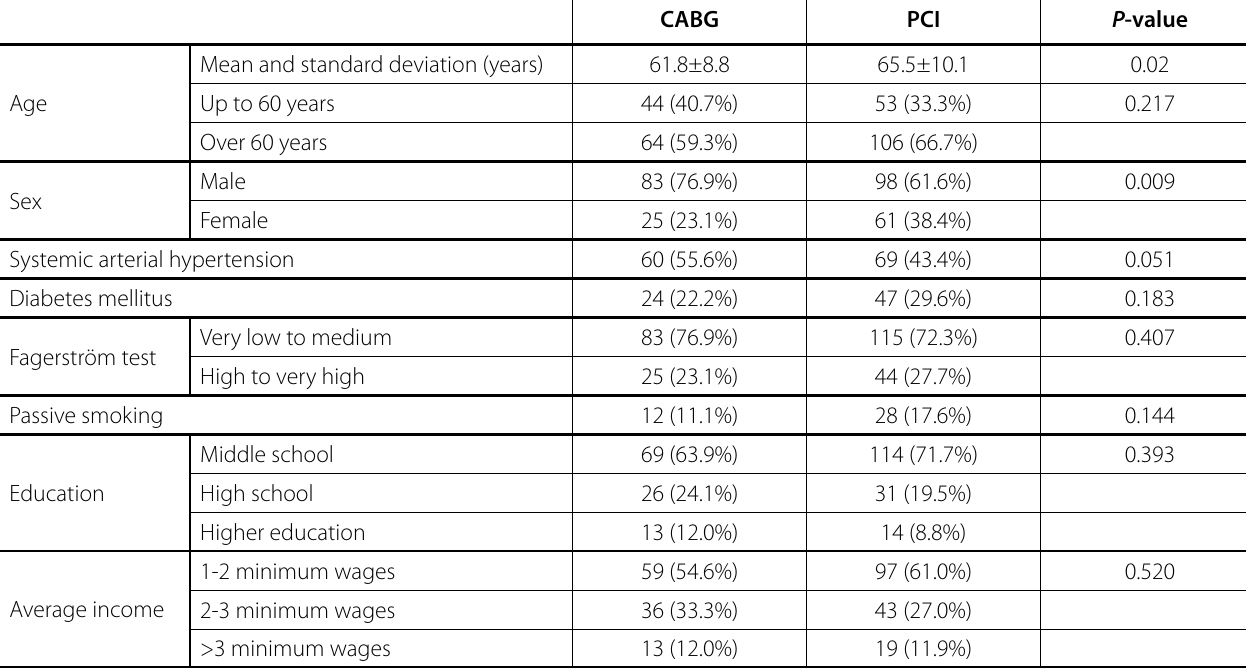
Table 1. Descriptive analysis of patients undergoing surgical revascularization (CABG) or percutaneous intervention